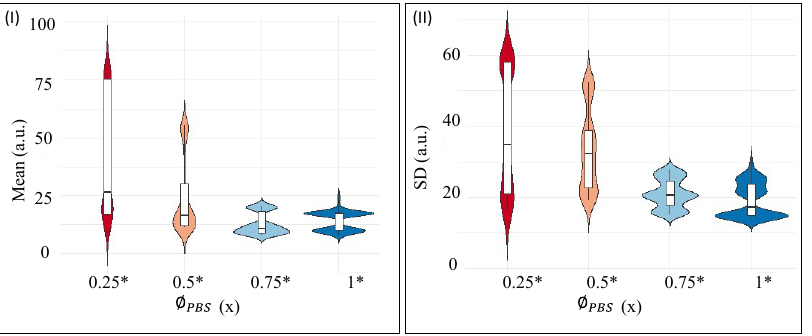
Figure 10. Violin plots for the first-order textural parameters. ( I ) represents the distribution of Mean, and ( II ) displays the distribution of Standard Deviation (SD) of the protein drops at different initial concentrations of PBS ( φ PBS ). The significant φ PBS is marked with an asterisk [*]. The protein drops have a fixed initial concentration of 9 wt% and contain a fixed volume of liquid crystals